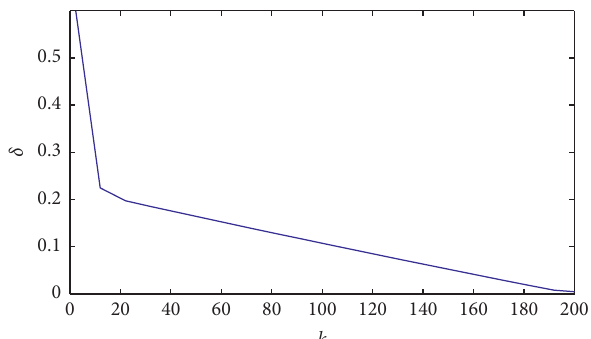
Figure 2: The parameter estimation errors δ versus k